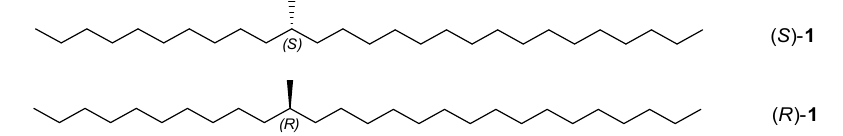
Figure 1. Contact sex pheromone of Tetropium fuscum and its enantiomer.